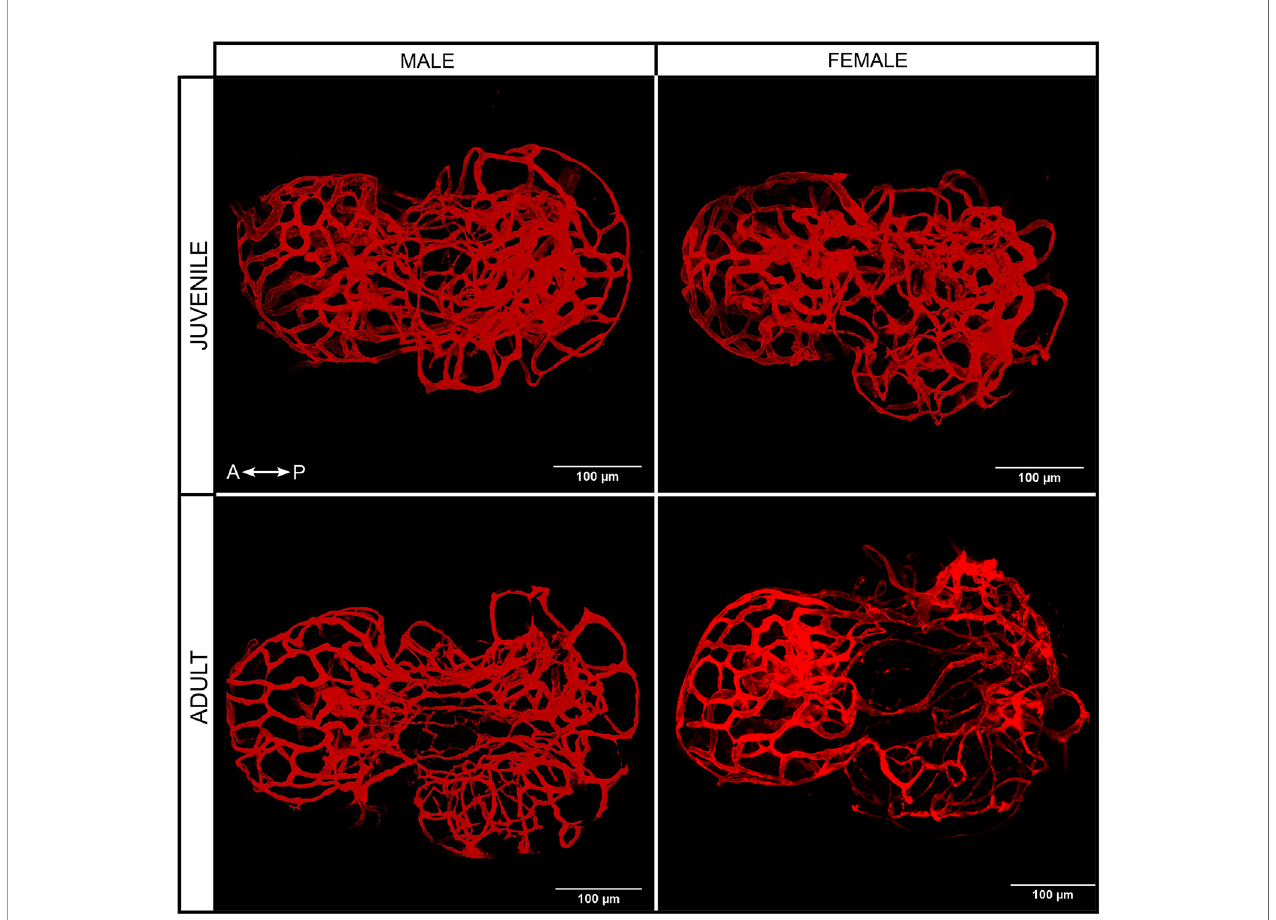
FIGURE 3 | 3D projection of blood vessels from juvenile and adult male and female medaka pituitaries from the dorsal side. Left right arrow symbol shows the direction of the pituitary (A, anterior; P,